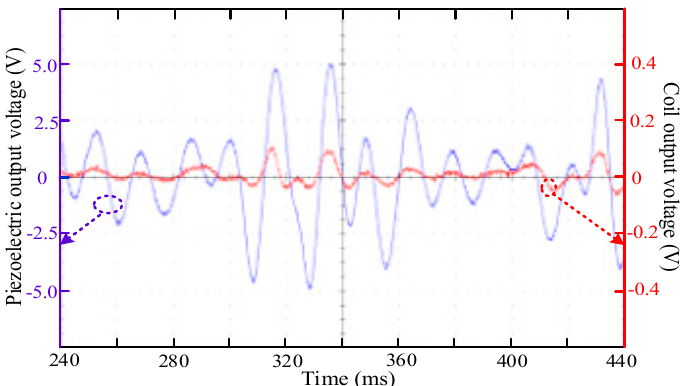
Figure 11. The output voltage wave forms of the piezoelectric beam and coil while rotating mass block random swing.